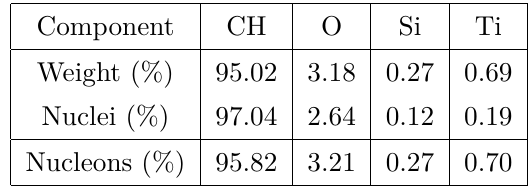
Table 2 . The same as table 1, but for the T2K experiment. Data taken from ref.